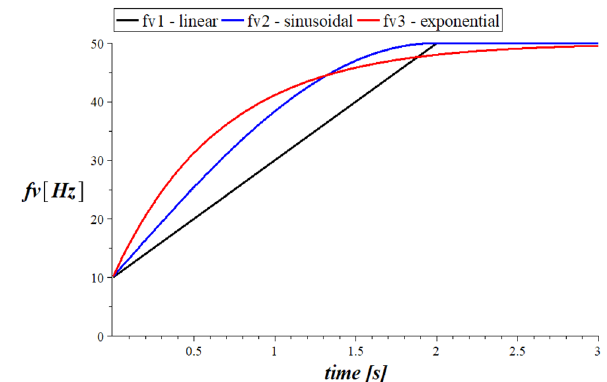
Fig. 1 Electric R,L circuit applied for further investigations